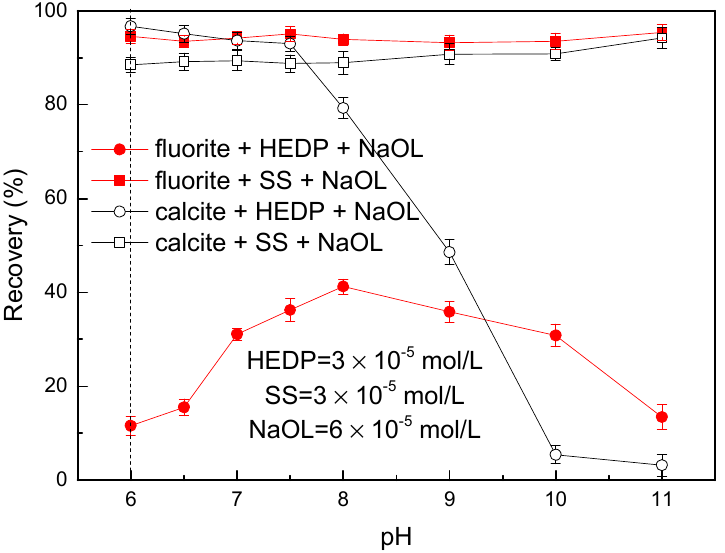
Figure 1. Effect of solution pH on the flotation behavior of fluorite and calcite using sodium oleate (NaOL) as collector and 1-hydroxyethylidene-1,1-diphosphonic acid (HEDP) or sodium silicate (SS) as depressant.